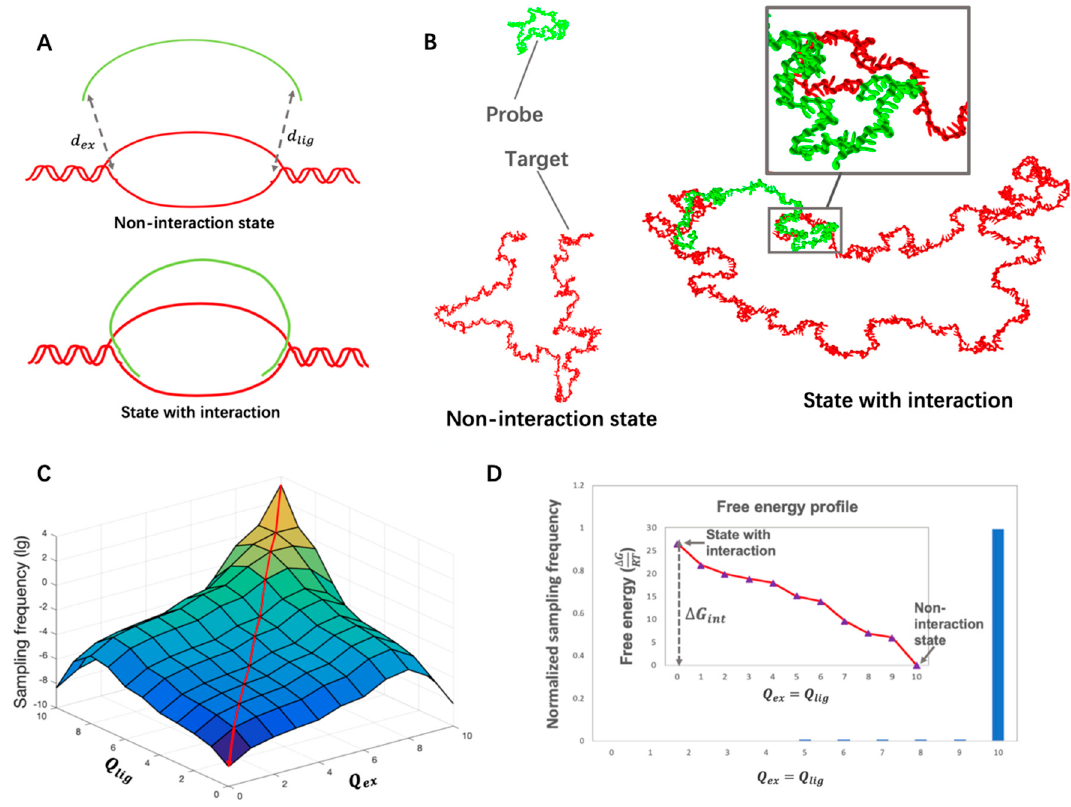
Figure 1. ( A , B ): Diagram and oxDNA visualization showing non-interaction / interaction state of the target and gene. ( A ) A diagram showing the non-interaction / interaction states. d ex and d lig respectively represent the distances between the extension arm and its complementary region on the target gene and the ligation arm and its complementary region on the target gene. These two